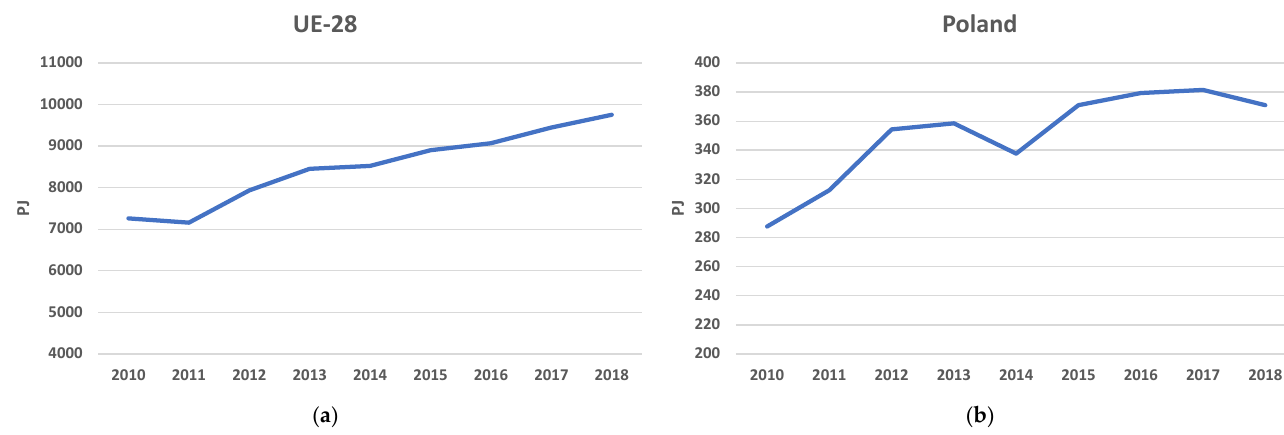
Figure 1. Total primary energy generation of renewables in EU-28 (a) and in Poland (b) (in PJ). Own study, based on [31].